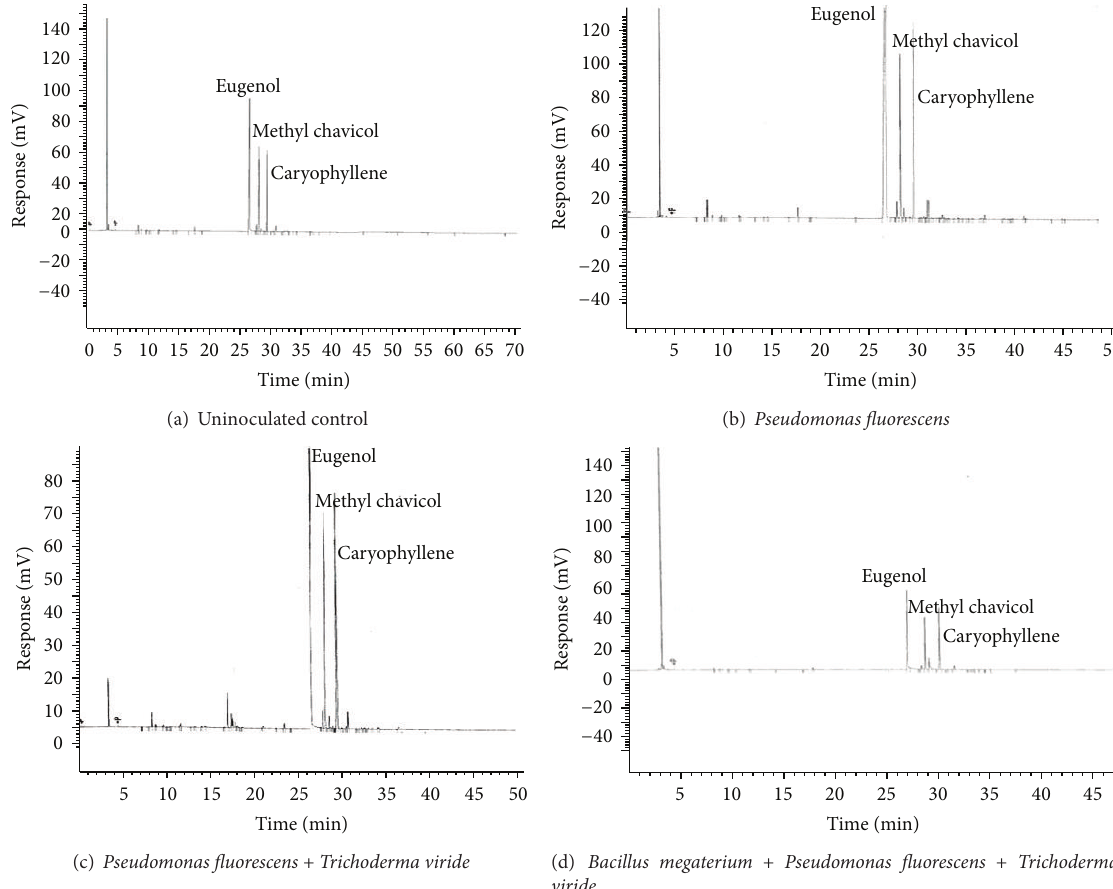
Figure 3: GC chromatograms of selected microbial treatments depicting major essential oil